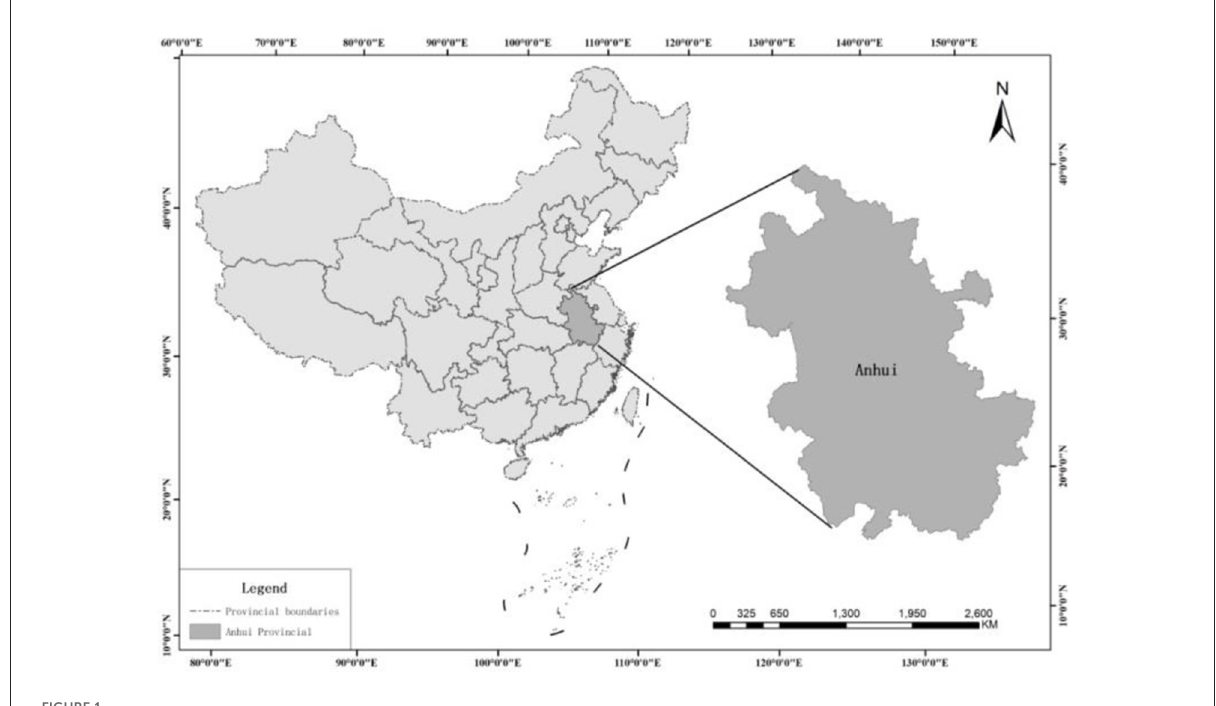
FIGURE1 Location of Anhui province in